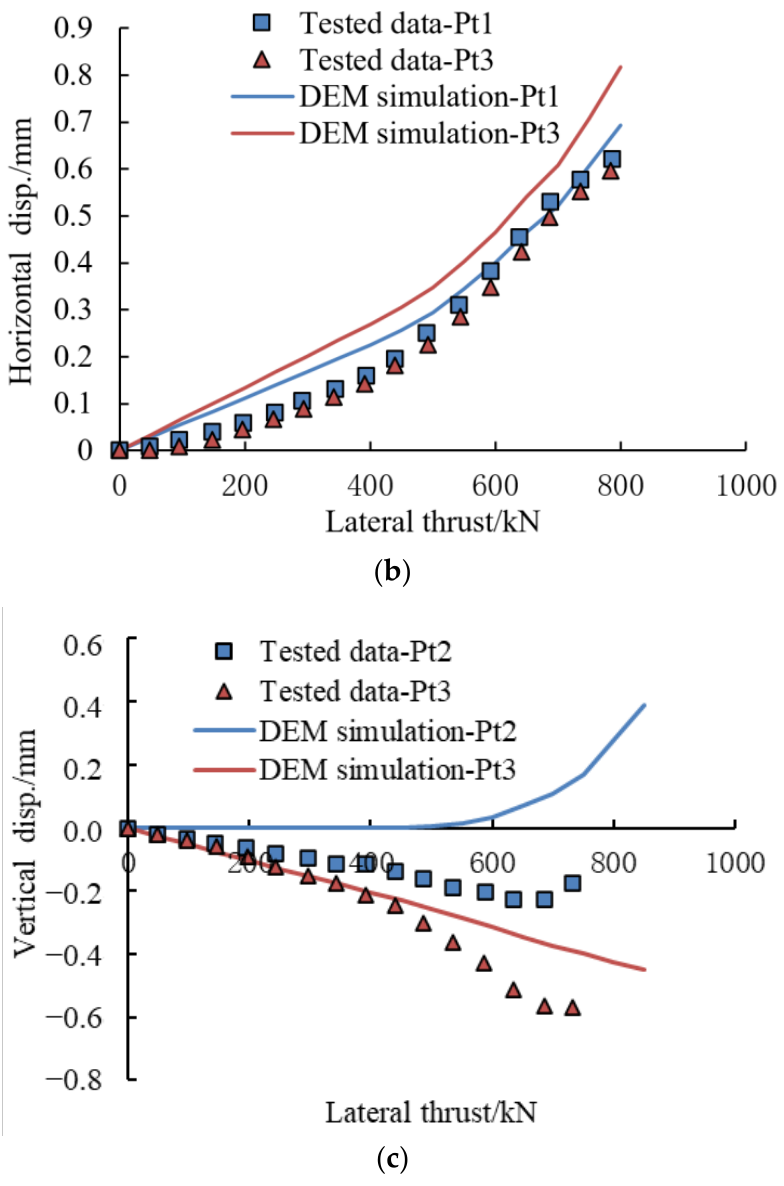
Figure 9. Comparison of tested displacement with the DEM prediction. ( a ) Location of the displacement monitoring points and convention of directions; ( b ) Comparison of tested horizontal displacement with the DEM prediction; ( c ) Comparison of tested vertical displacement with the DEM prediction.